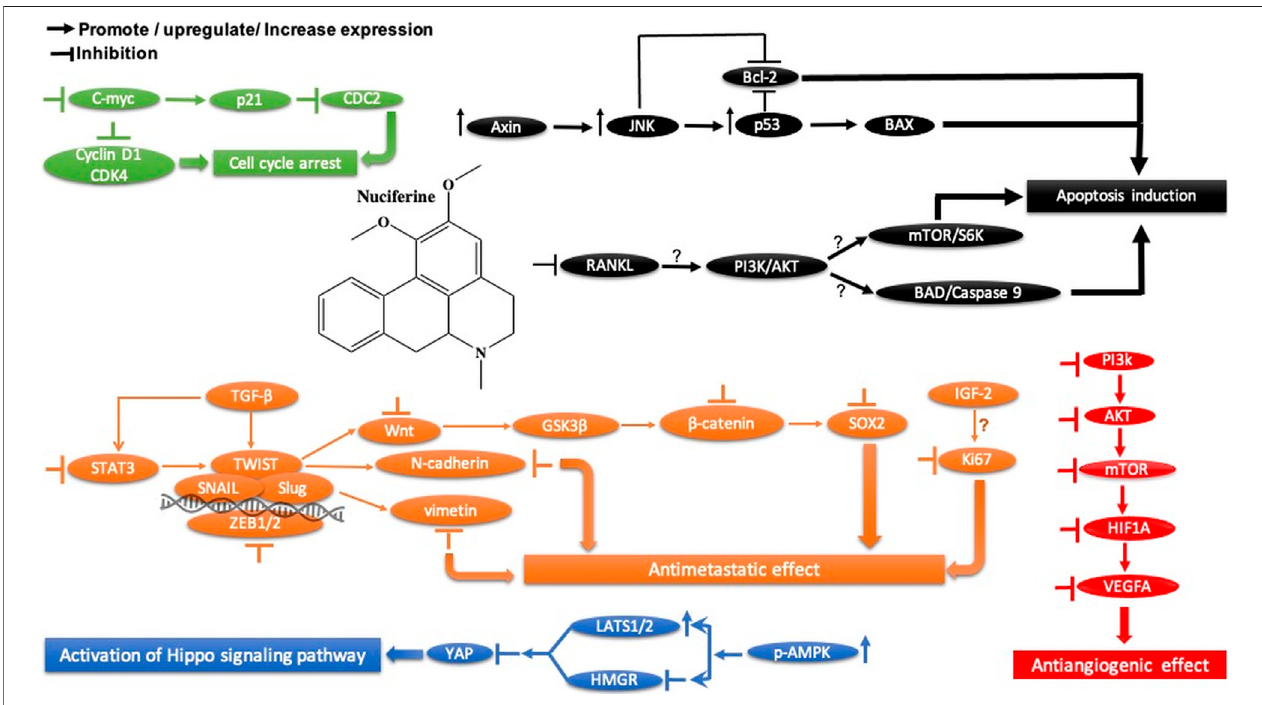
FIGURE 6 | Main mechanism of nuciferine against